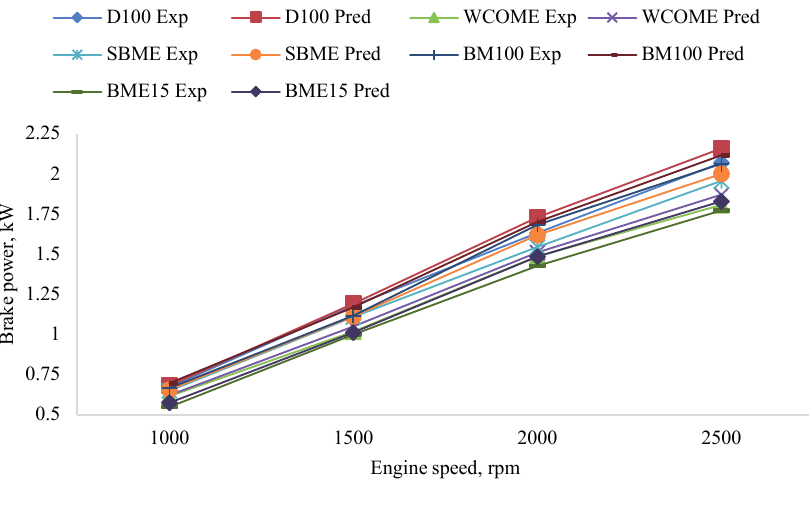
Fig. 2. Variation of brake power with engine